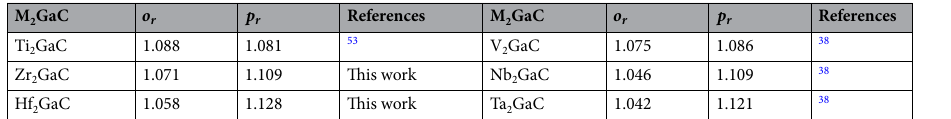
Table 3. The distortion parameters of octahedra ( o r ) and trigonal prisms ( p r ) of M 2 GaC (M = IV-B and V-B group transition metals) MAX crystal